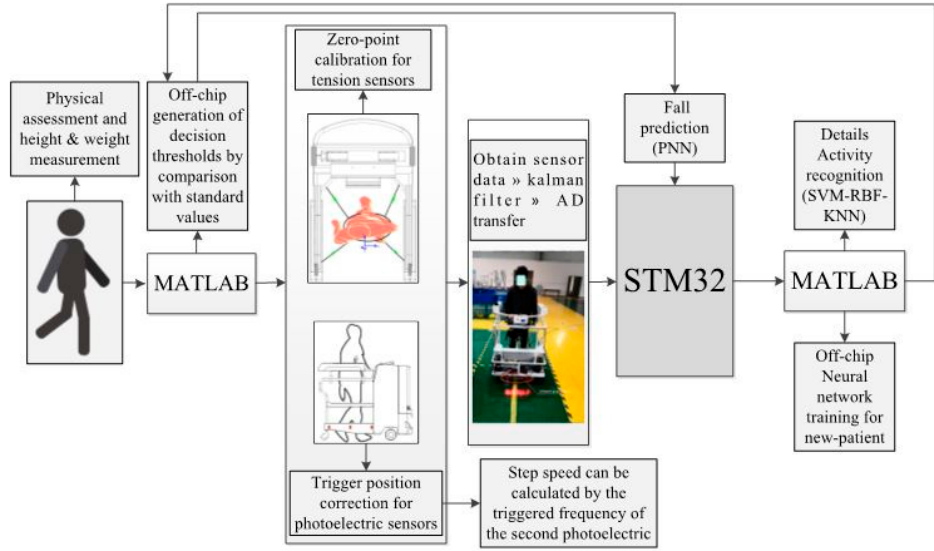
Figure 1. Mobile chaperonage lower limb rehabilitation-training robot (MCLLRTR) prototype.